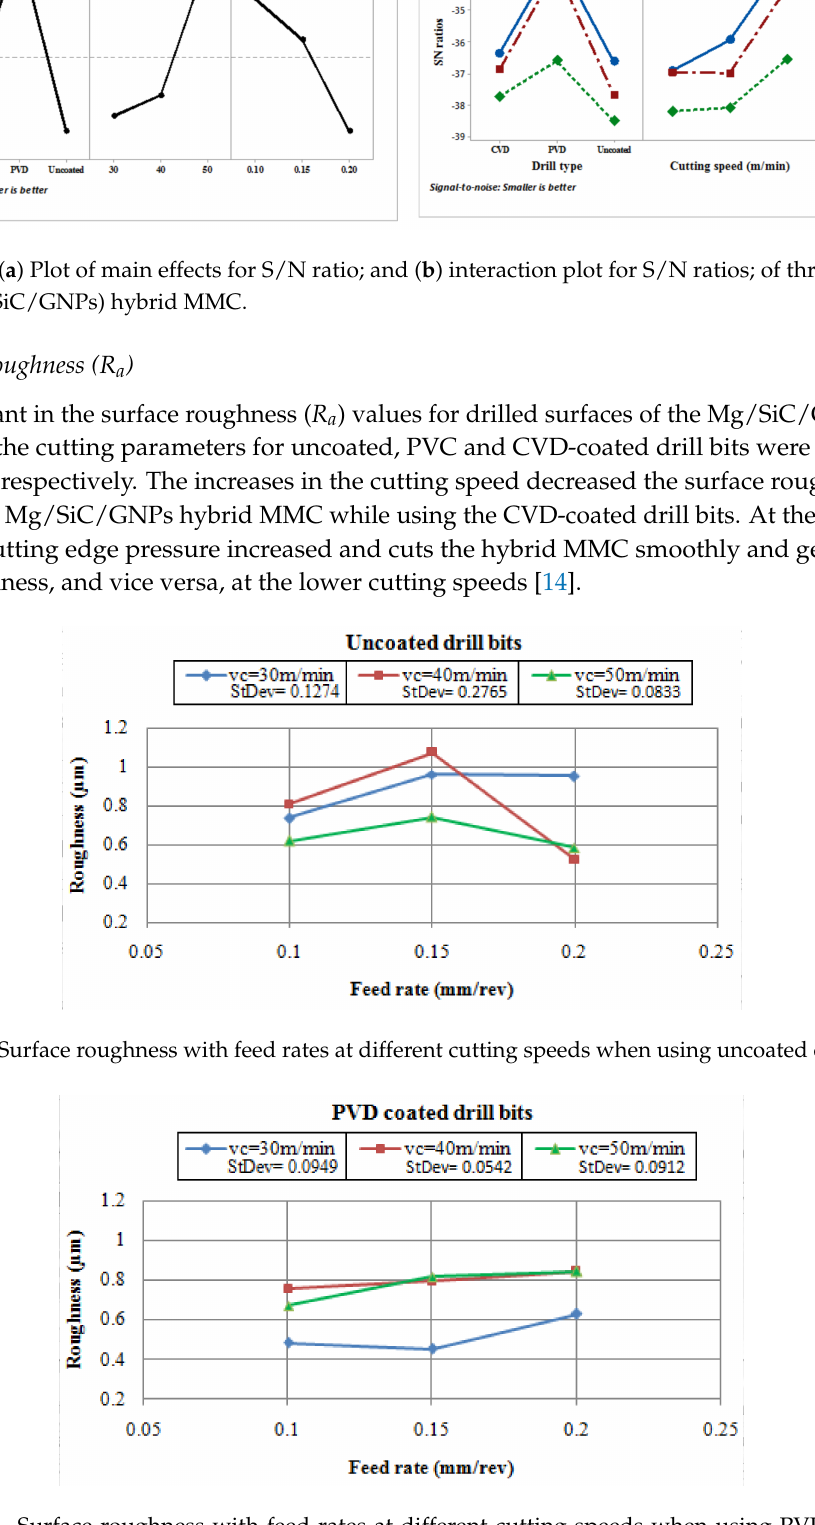
Figure 10. Surface roughness with feed rates at different cutting speeds when using PVD-coated drill